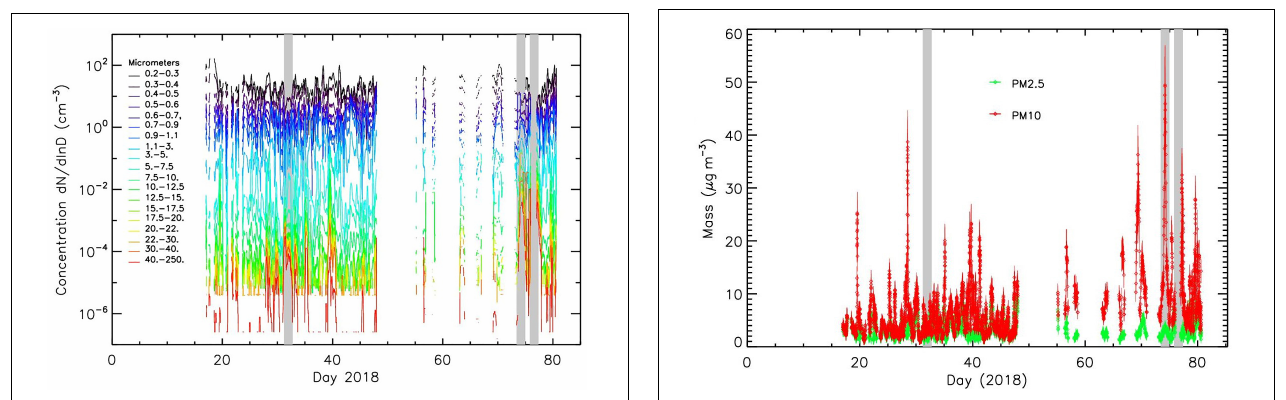
FIGURE 2 | Evolution of the LOAC concentrations for the 19 size classes; the three events are indicated by gray zones.